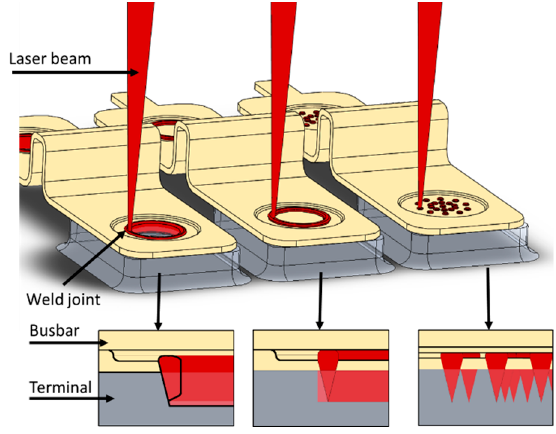
Figure 5. Standard methods of laser joining battery connections: fillet joint ( left ), lap joint ( middle ), multiple spot welds ( right ).